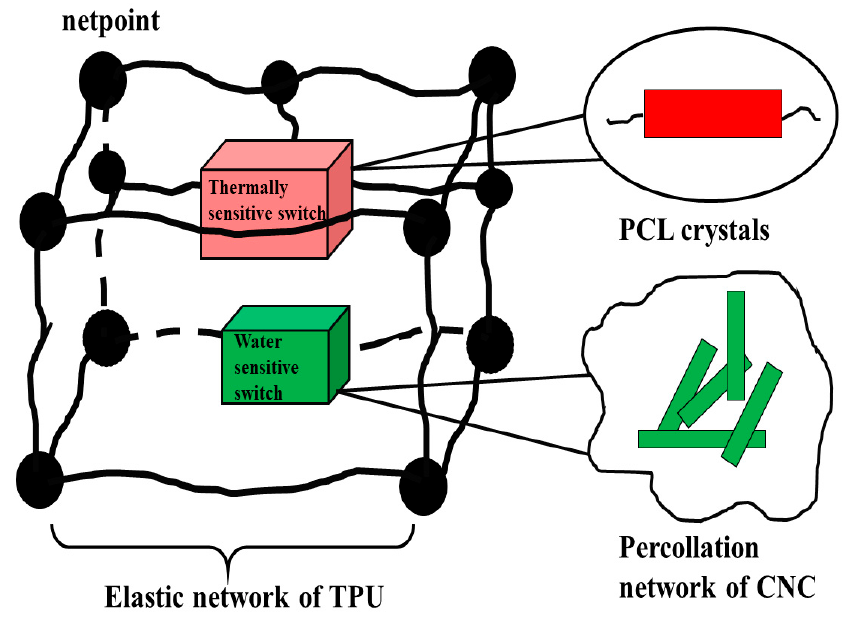
Figure 14. Structure of the TPU/CNC nanocomposites with twin switches. Adapted from [188].